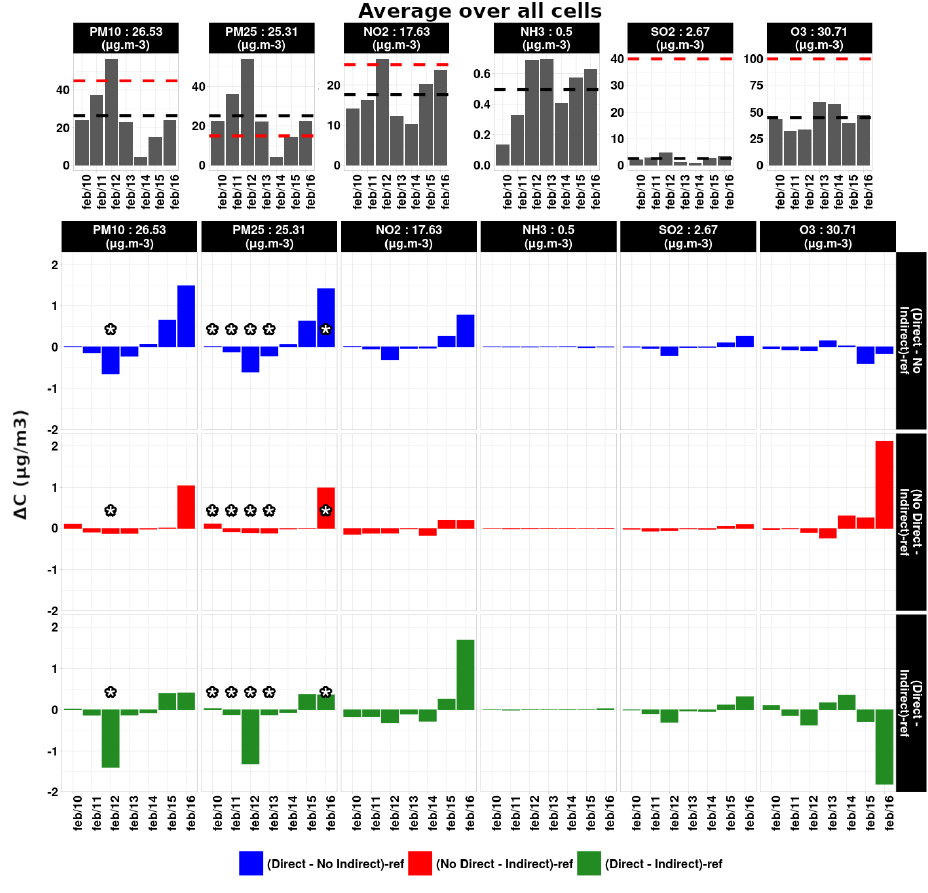
Figure 9. The additional effect of coupling to emission reduction scenarios. Three cases are presented: Direct effects but no indirect effects, indirect effects but no direct effects and both direct and indirect effects for the entire domain (on the left) and only the urban cells (on the right). For each case, the coupled case scenario is compared to its base case scenario (each time with the same coupling effects), then the difference with the reference case is calculated to obtain the additional effect of the coupling. A star is added to each day if the concentration passes the guidelines even after the emission reductions. Above each panel, the concentration for the reference case is given. Red lines on the reference case shows the WHO guideline, and the black dashed line shows the average of the